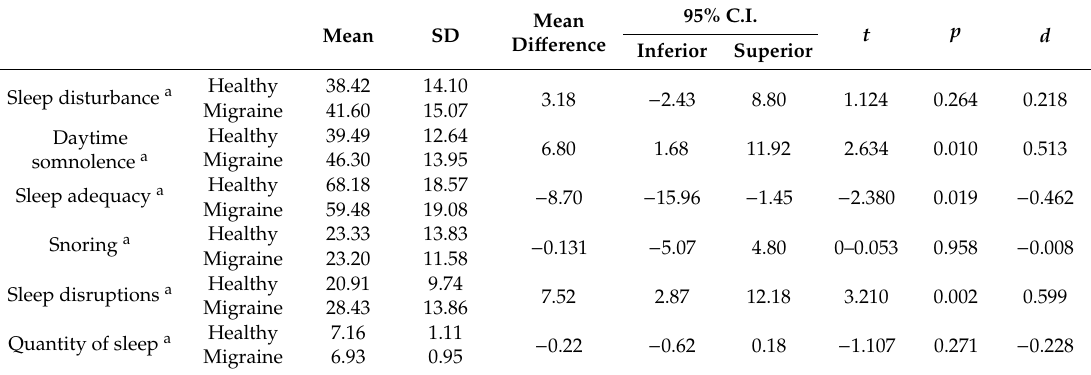
Table 2. Between-group di ff erences in sleep